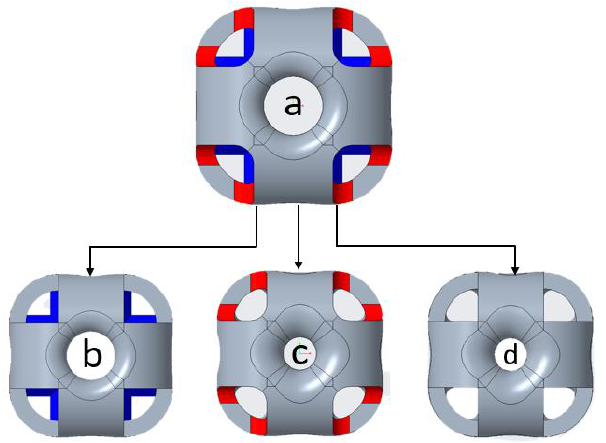
Figure 15. Recommended design strategies for OS-T structure to eliminate powder